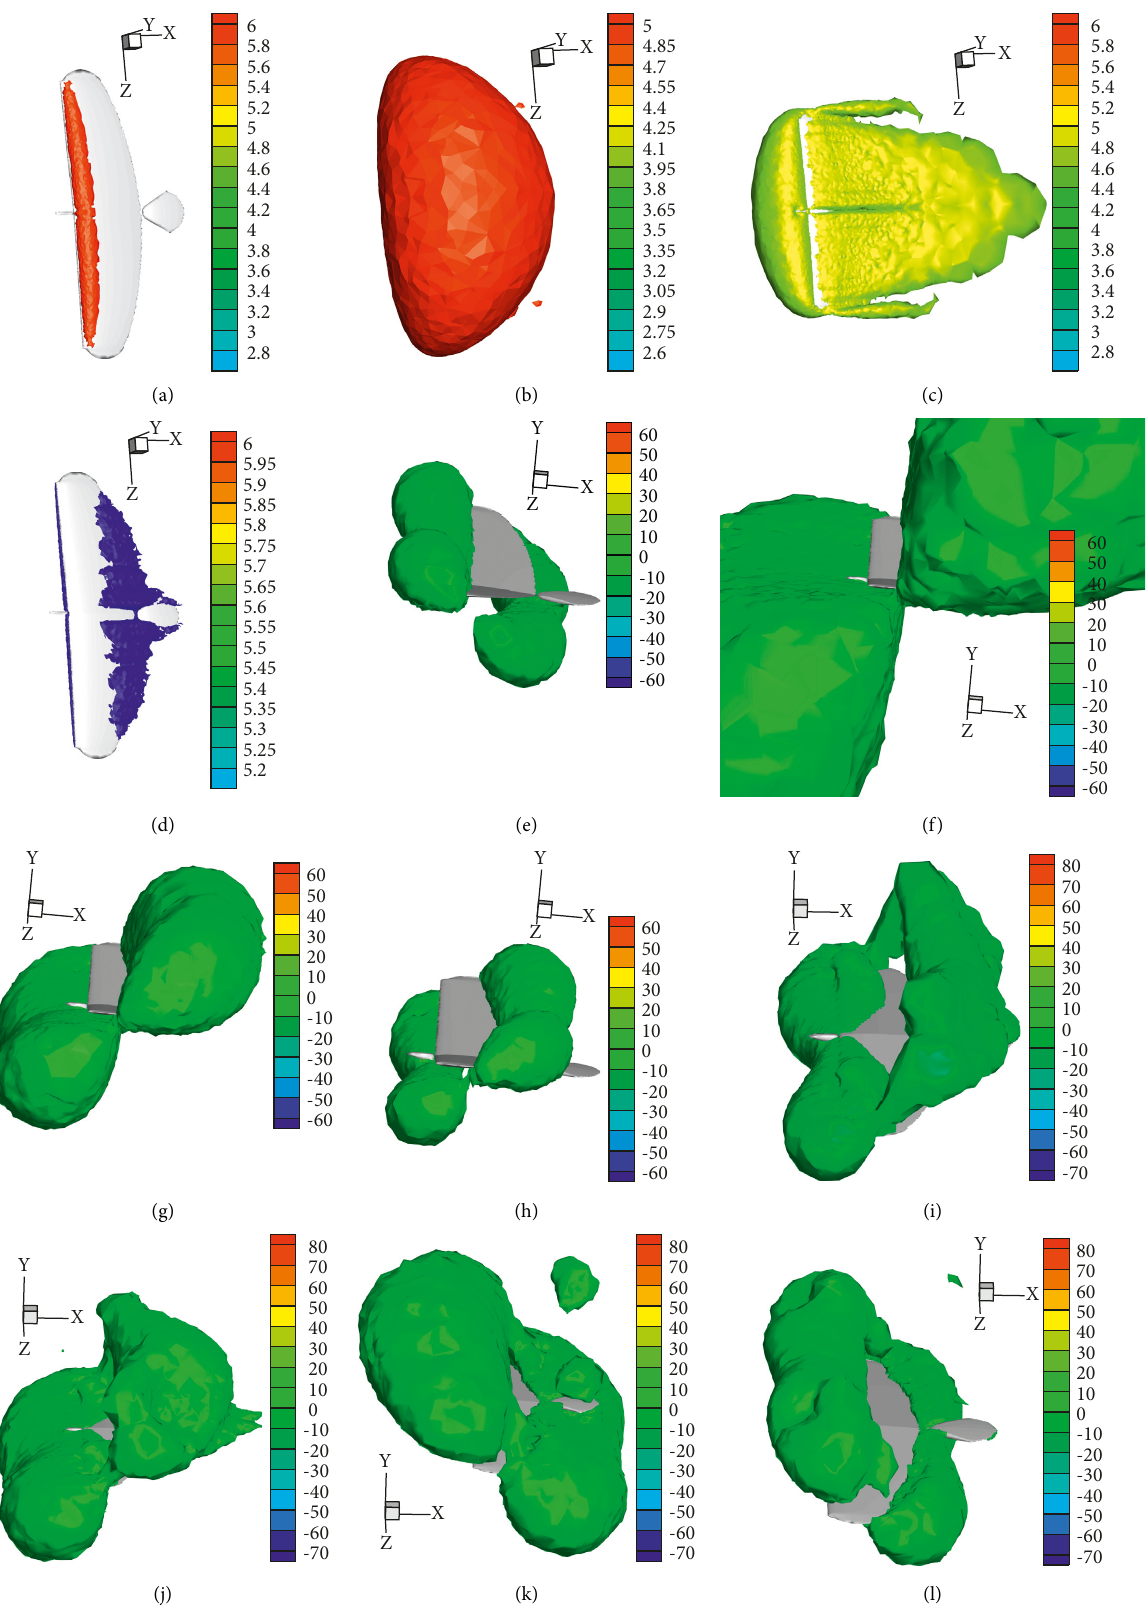
Figure 11: Velocity iso-surfaces of the flapping wing robot. (a), (b), (c) and (d): air velocity v � 6, 5, 4.8 and 3 in the steady state; (e), (f), (g) and (h): air velocity v � 0, 5, 6 and 10 in the transient state when the wing flaps upwards; (i), (j), (k) and (l): air velocity v � 0, 4, 6 and 10 in the transient state when the wing flaps